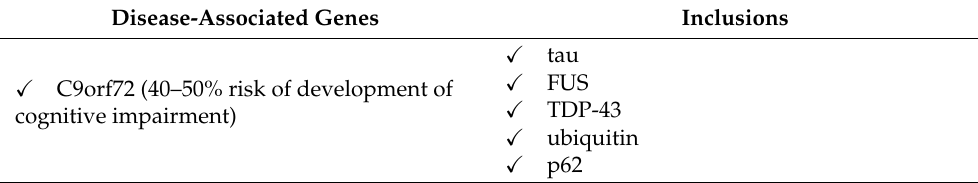
Table 3. Summary of characteristics genes and inclusions in ALS-FTSD